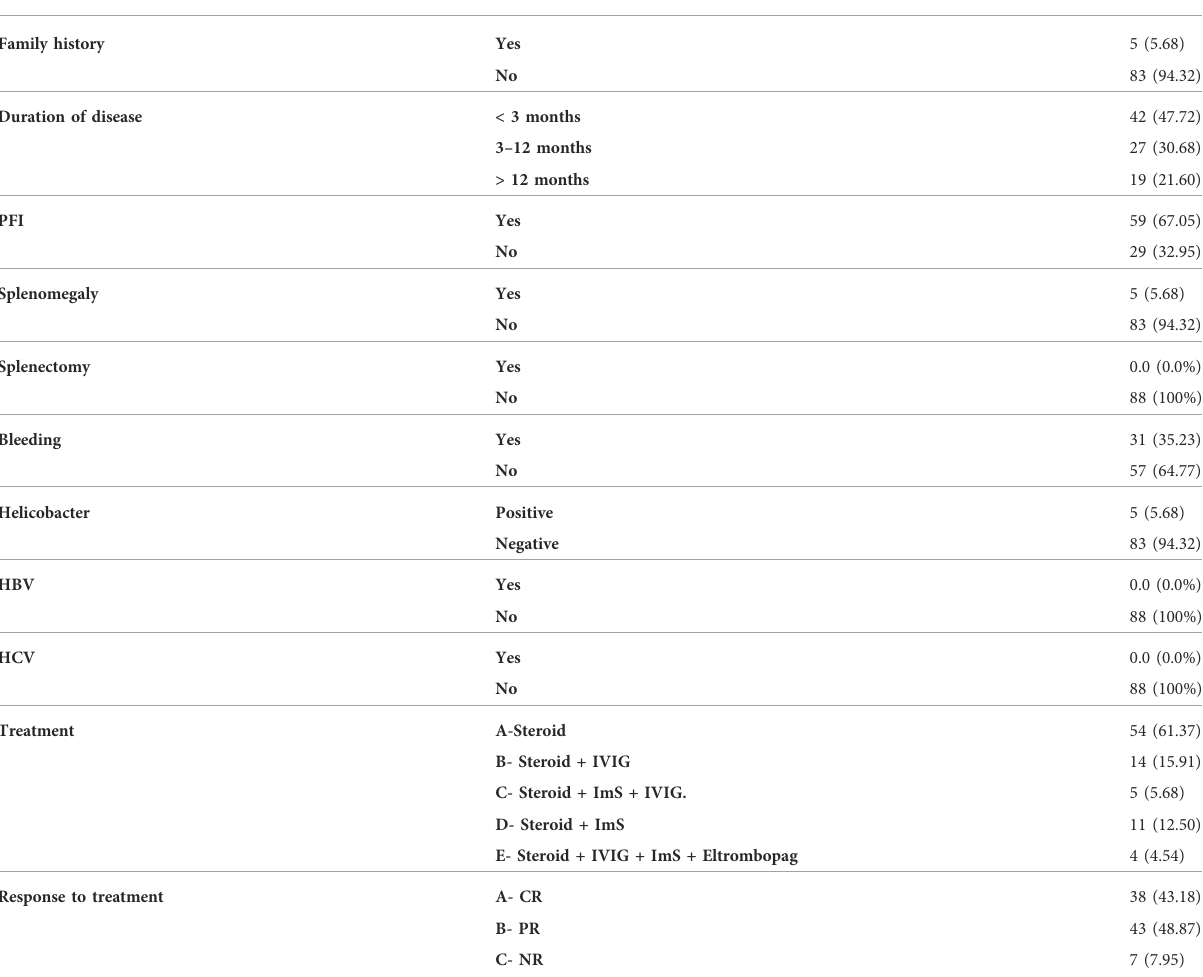
TABLE 2ThedetailsofITP groupclinical characters concerning family history,durationofdisease,symptoms,